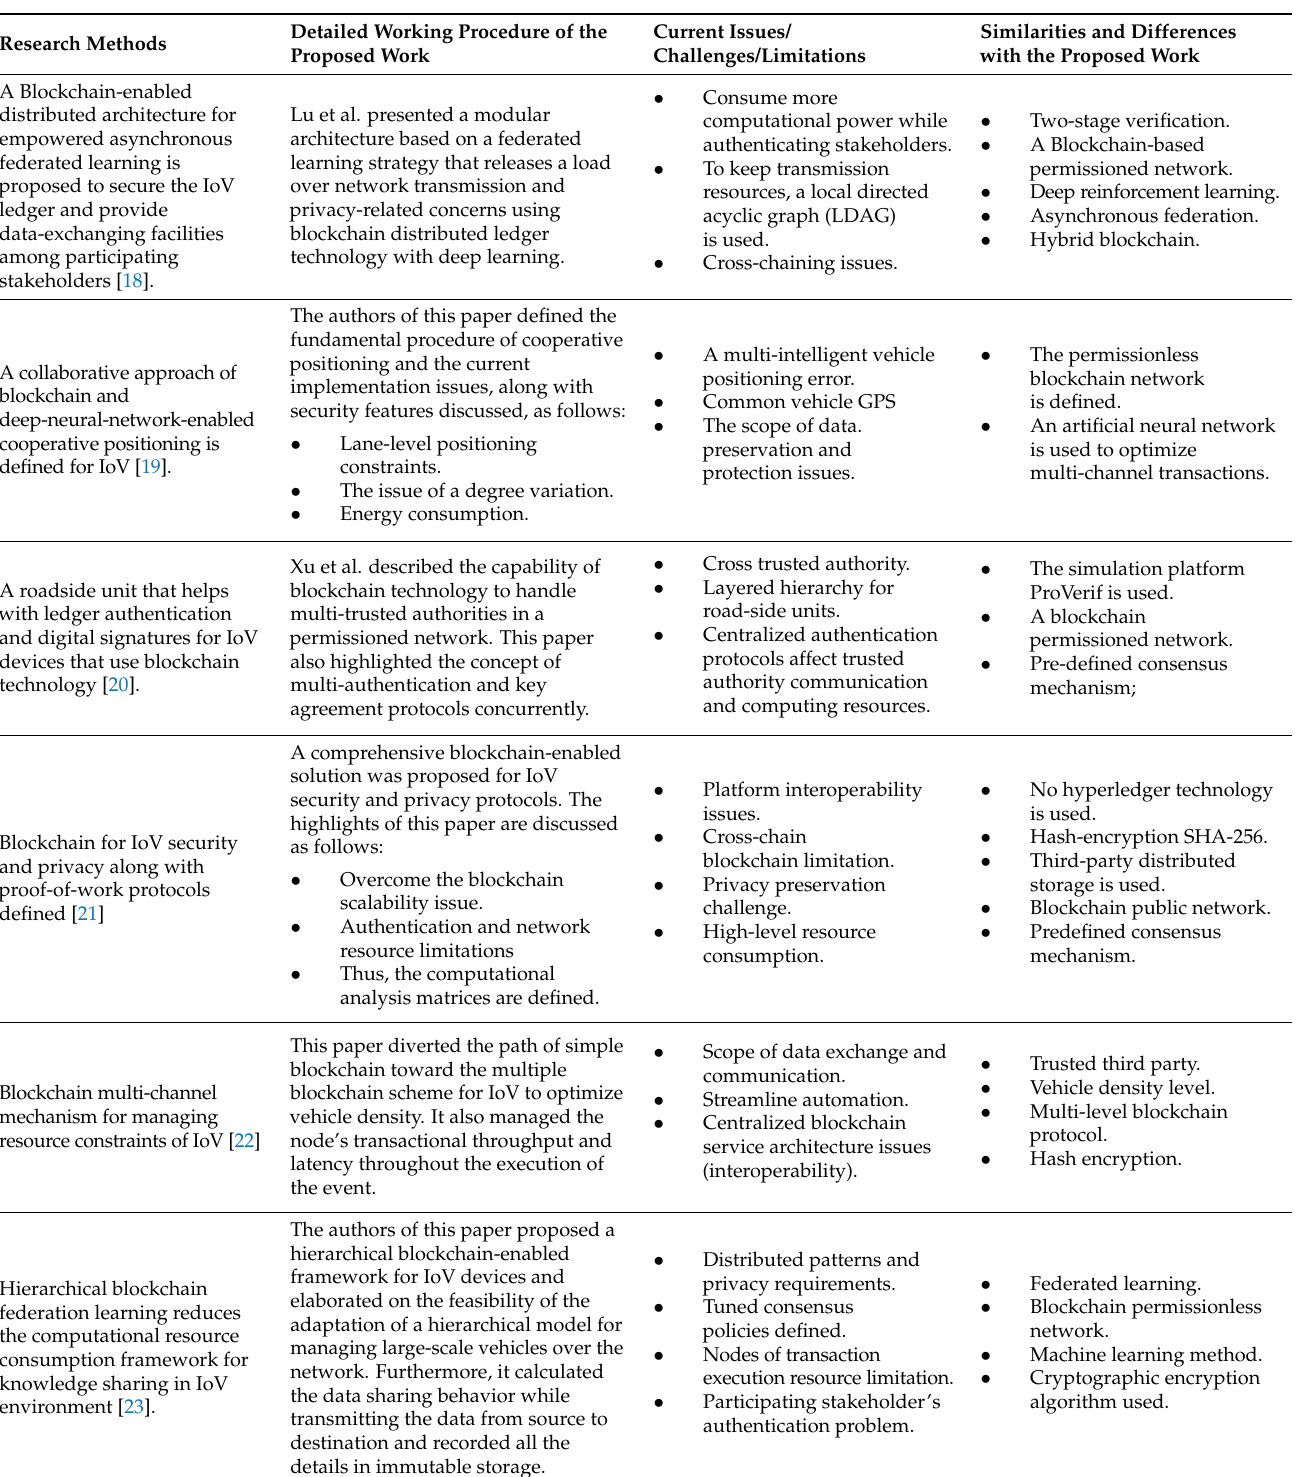
Table 1. Literature on Blockchain Smart Contracts and Hyperledger-Technology-Enabled Architecture for IoV Security and